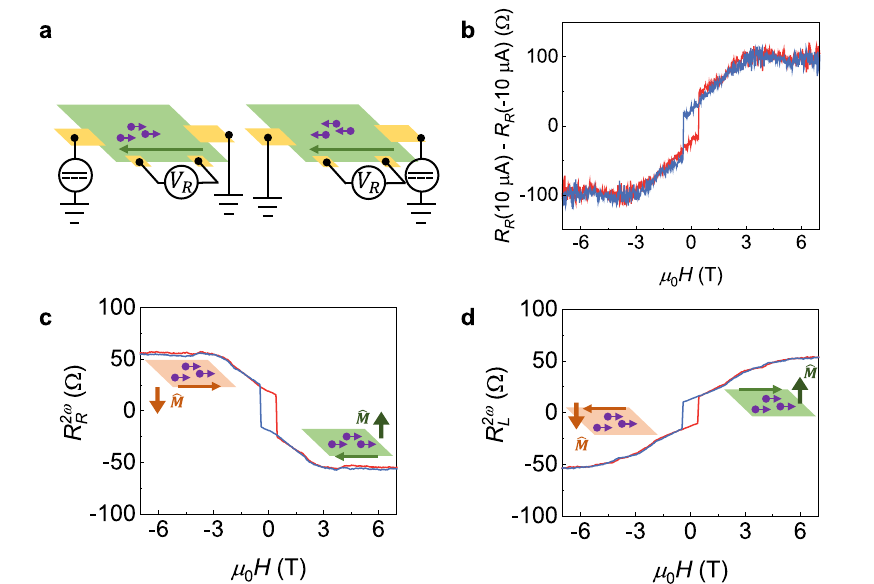
Fig. 2 | Non-reciprocal charge transport in a 5-SL MnBi 2 Te 4 . a Schematic illus- trations of current direction dependent backscattering of edge transport. The chiral edge states are indicated by green arrows. b Resistance difference between positiveandnegativecurrentasafunctionofthemagnetic fi eld.Themeasurement isperformedat11Kwithtopgatevoltageof − 2V. c , d Thenon-reciprocalresistance